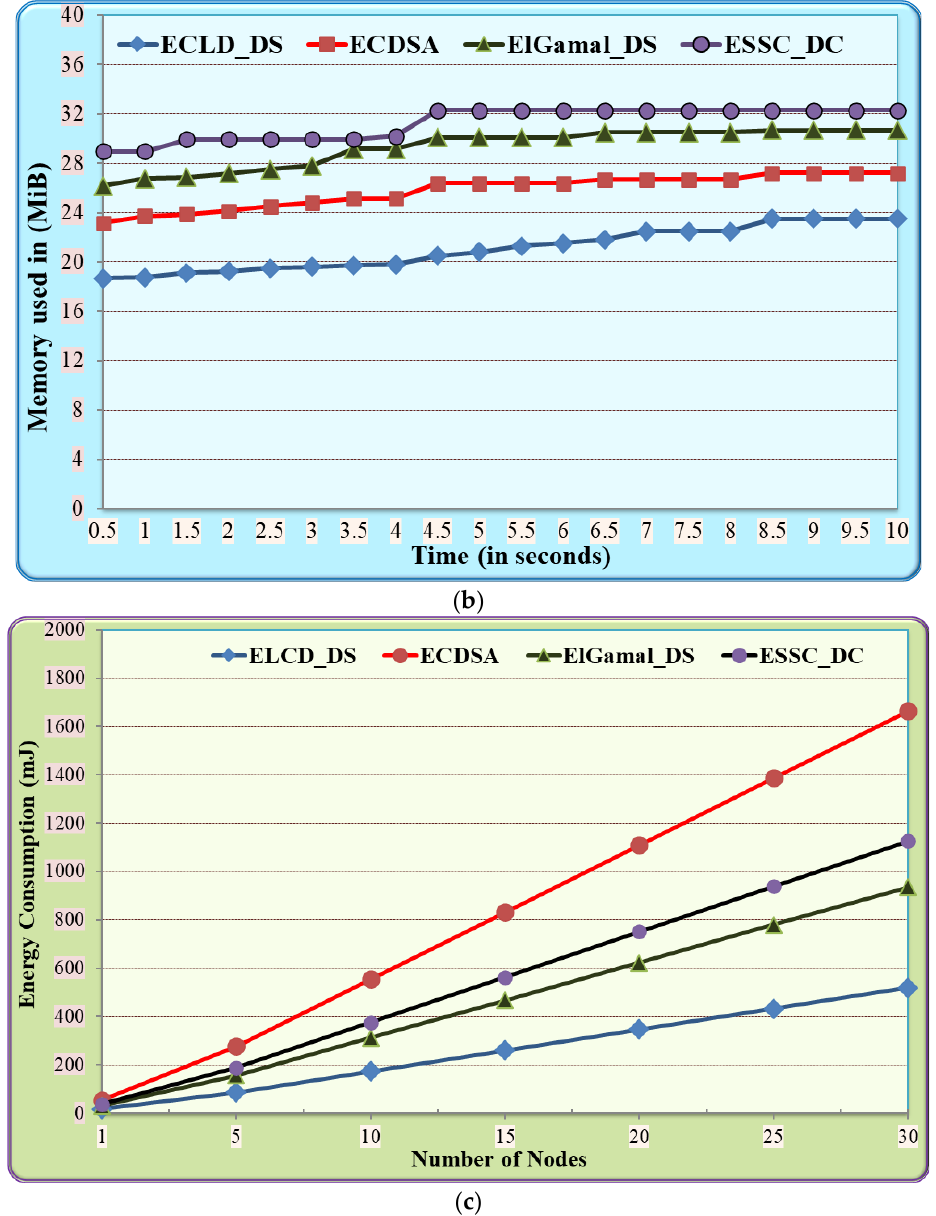
Figure 6. Performance comparison between ELCD digital signature and baseline algorithms on IoT ( a ) execution time; ( b ) storage cost; ( c ) energy consumption.